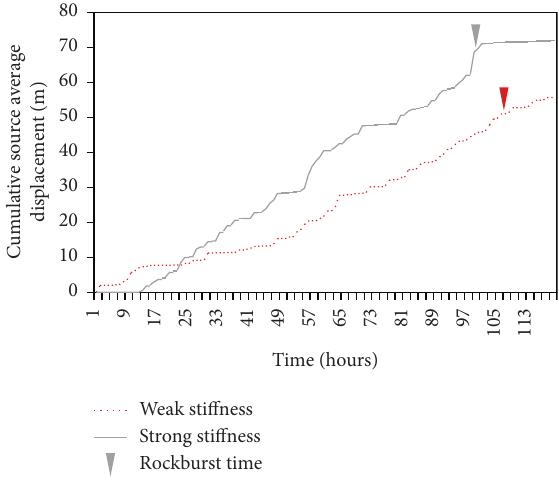
Figure 6: Characteristics of source average displacement in rockburst